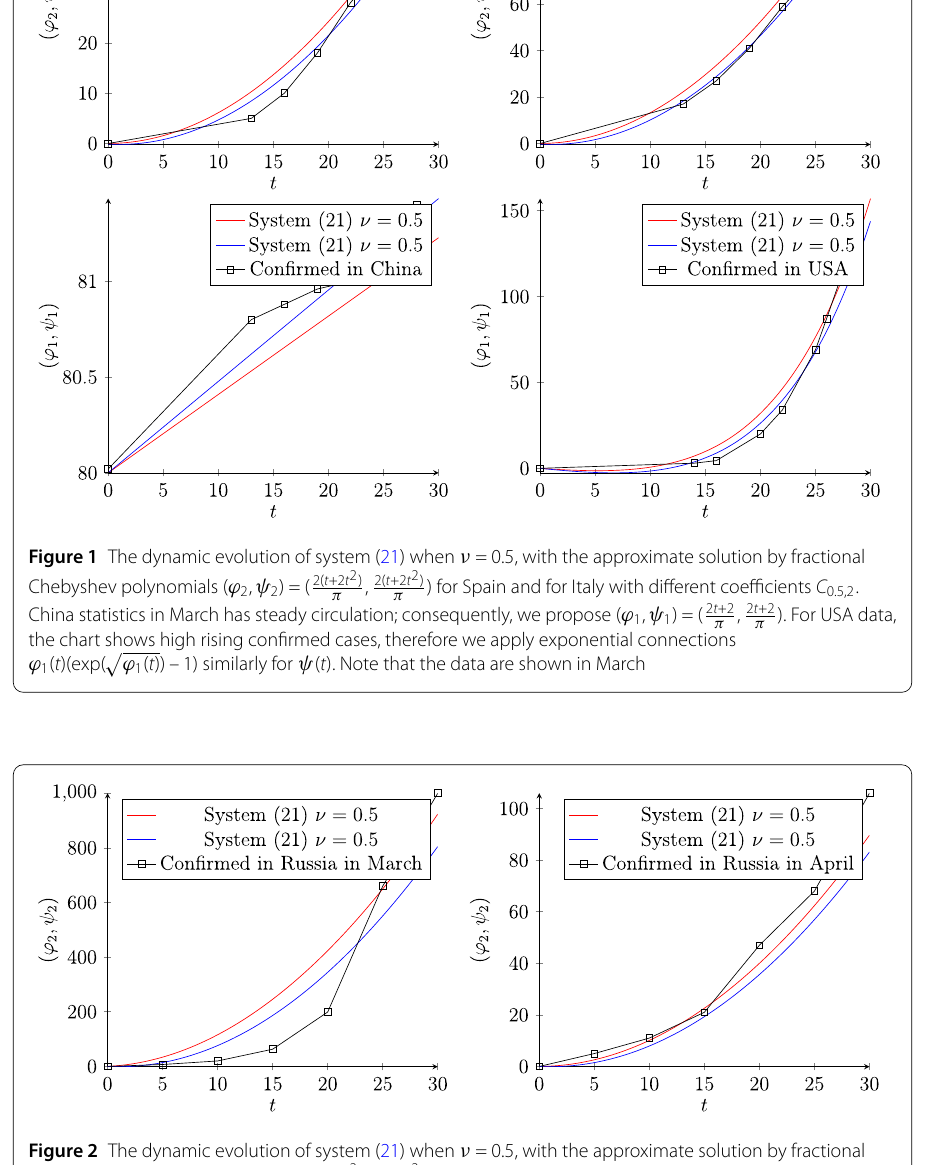
but it is still approximated by ( ϕ 2 , ψ 2 ). We confirmed that the approximate solution by fractional Chebyshev polynomials fits the future expectation of the number of infections. We added also the case of Brazil. The picture is similar also for Brazil data, which indicates huge changes from March to April (see Fig.